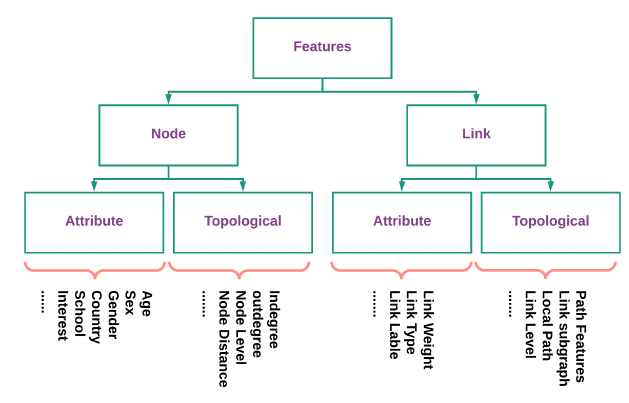
Figure 14. Taxonomy of Features used for link